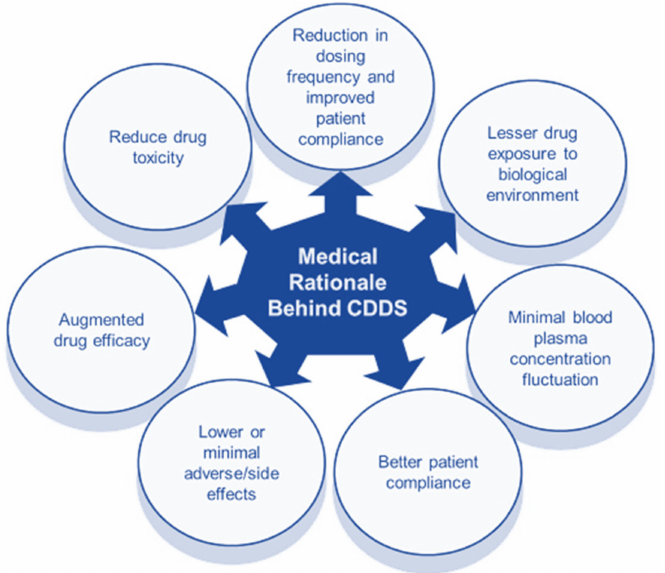
Figure 21. Medical Rationale behind controlled release drug delivery systems (CRDDS).